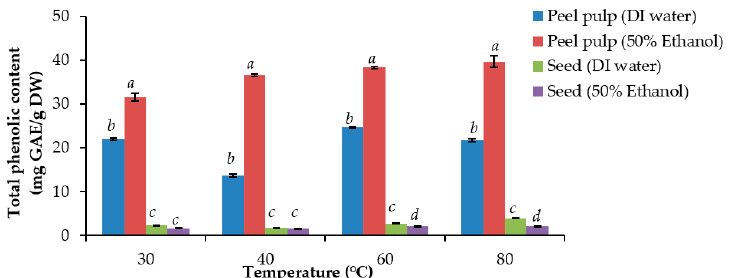
Figure 5. Total phenolic content of jujube peel pulp and seeds extracted with DI water and 50% ethanol at different temperatures. The error bar represents the standard error of the mean. Temperatures in the histogram with the same letter were not significantly different at the 5% level, according to the results of the LSD test.